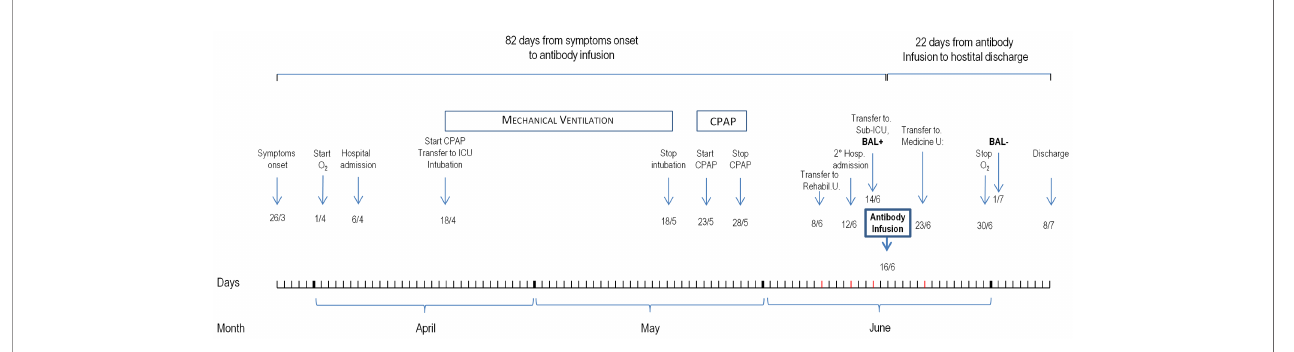
FIGURE 1 | Patient outcome from symptoms onset to